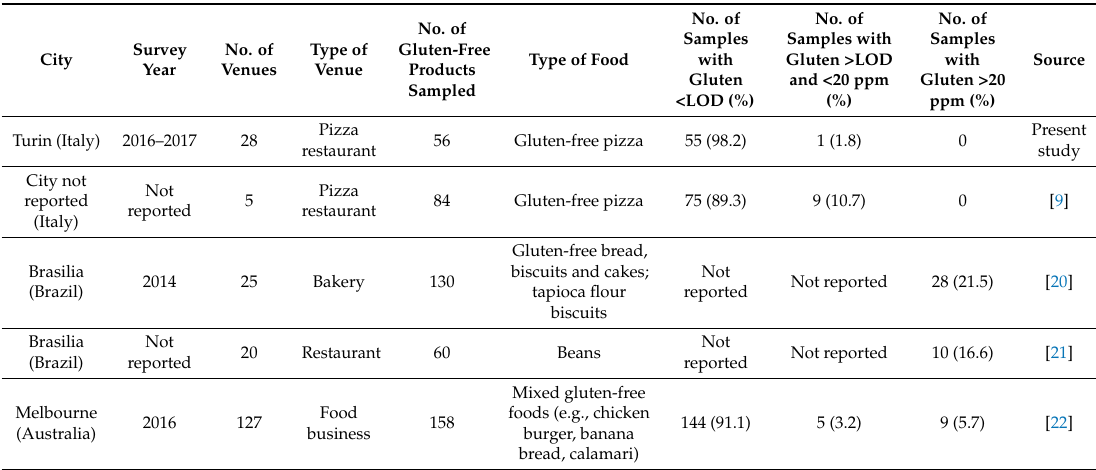
Table 2. Results of surveys on gluten content in declared or expected gluten-free foods from restaurants and other food